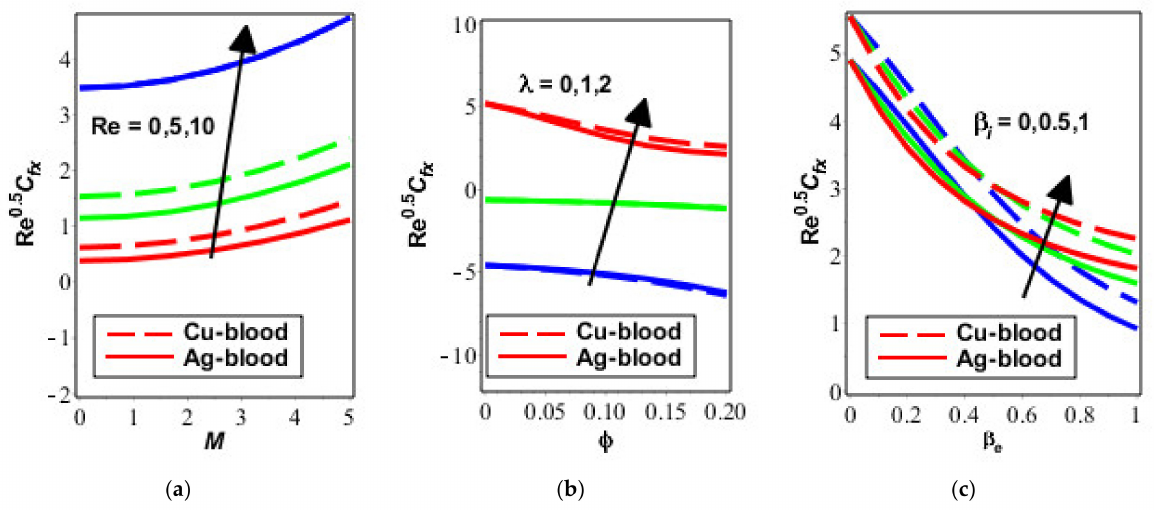
Figure 11. Behaviour of Re 1/2 C fx as varying ( a ) M and Re ( b ) φ and λ ( c ) β i and β e .